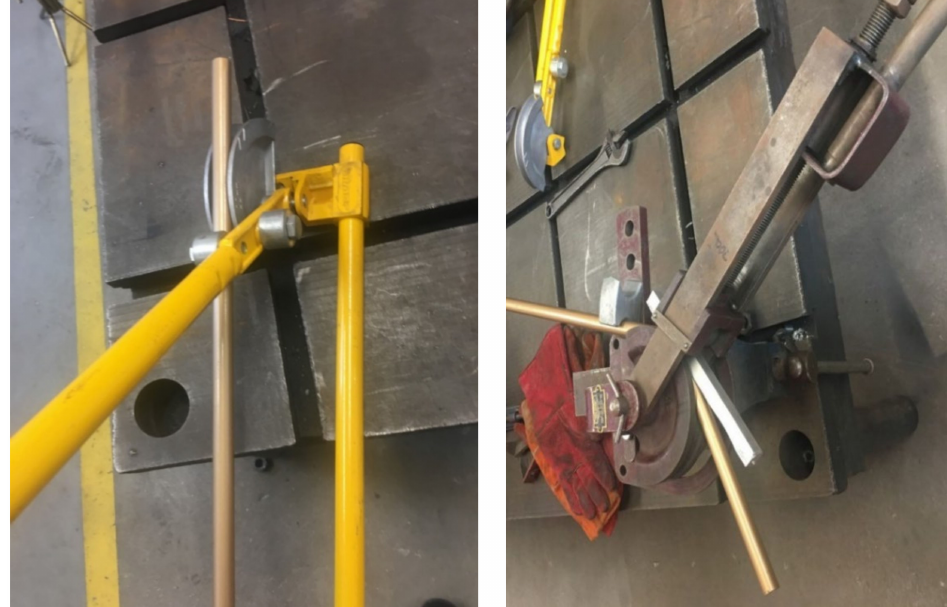
Figure 1. An application of tubular pipe bending using two methods conducted in Lancaster University Engineering